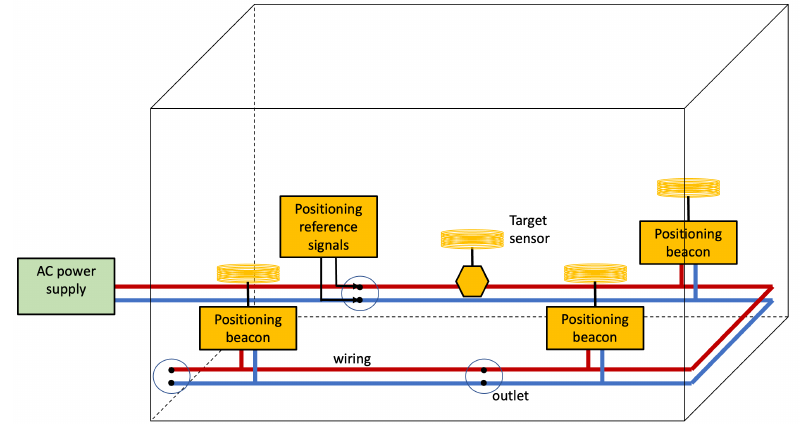
Figure 10. IBTB PLPS architecture using magnetic beacons. The PLPS components are highlighted in yellow. The electrical network delivers the positioning beacon to the anchor